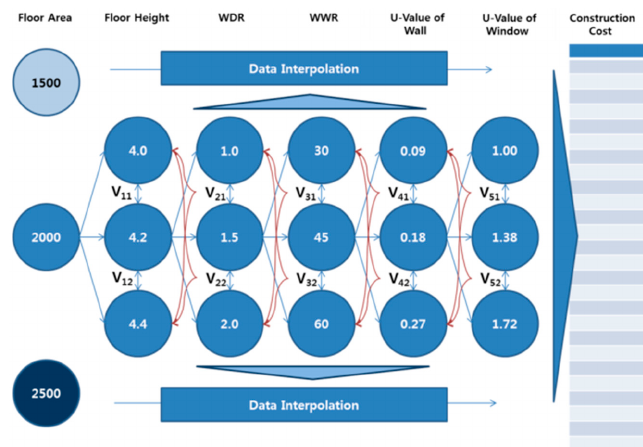
Figure 4. Model development data and step-by-step data interpolation.